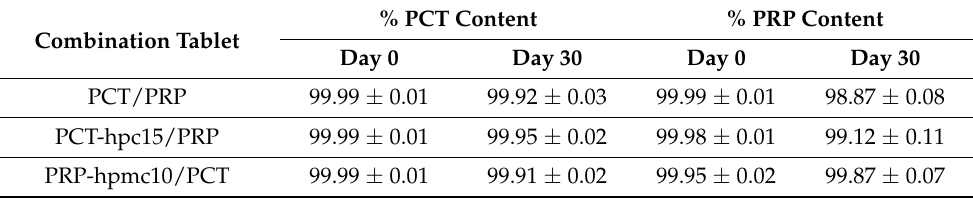
Table 8. Results of drug content analysis of tablets before and after the stability test.